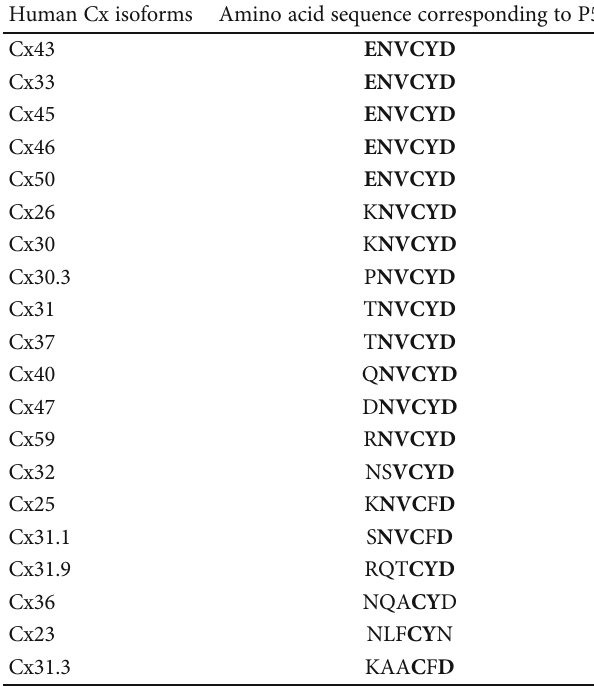
Table 1: Amino acid sequences in the EL1 of human Cxs corresponding to